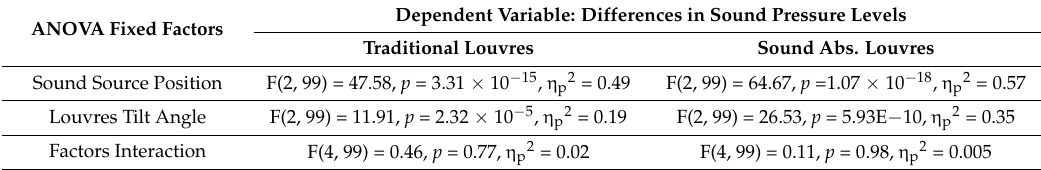
Table A4. Two-way Factorial ANOVAs results referred to the differences in Sound Pressure